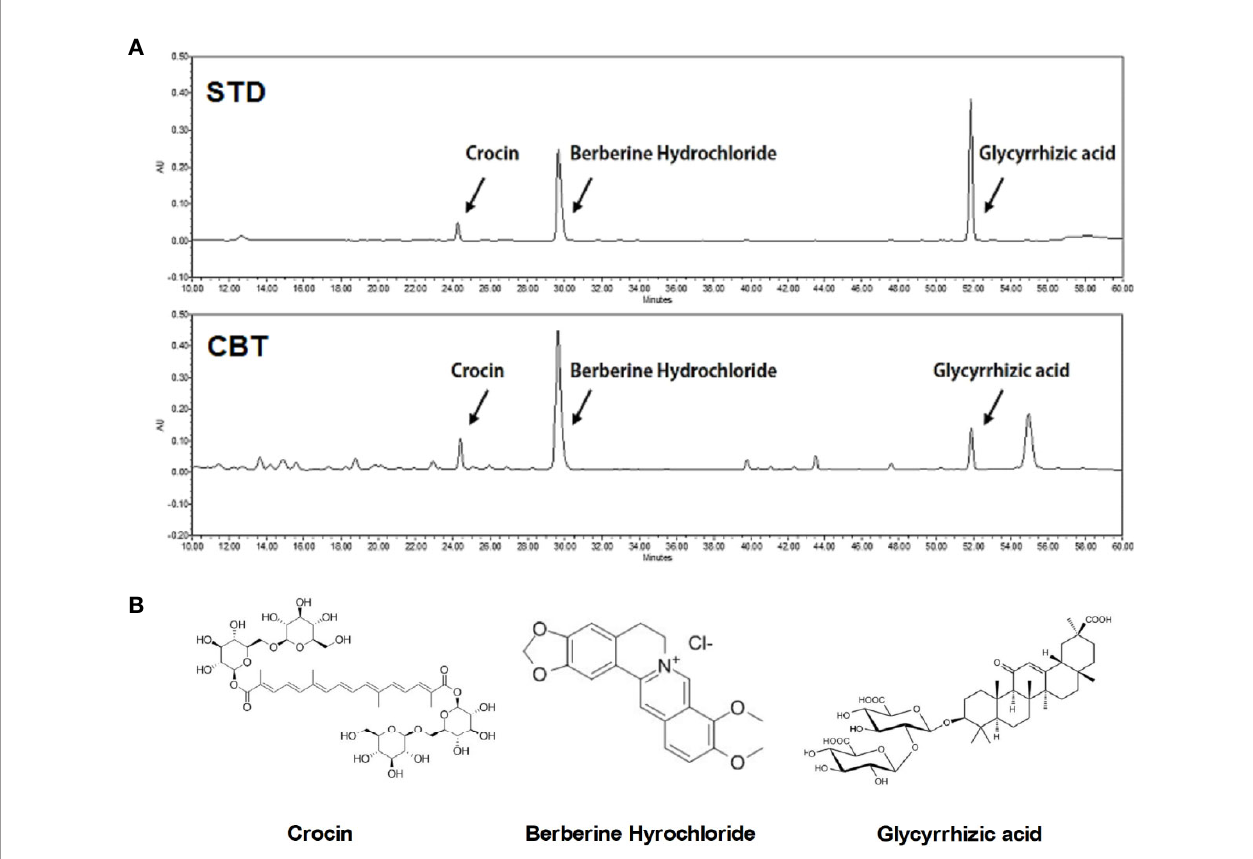
FIGURE 1 | High performance liquid chromatography ( HPLC) analysis of Chijabyukpi-tang (CBT). HPLC chromatograms of standard compound mixtures (STD) and CBT samples (A) . Chemical structures of crocin, berberine hydrochloride, and glycyrrhizic acid (B) .